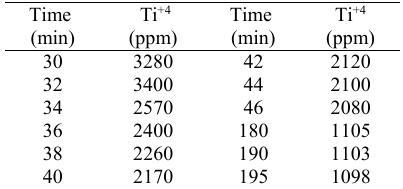
Table 1: Concentration variation of [Ti] +4 via time.